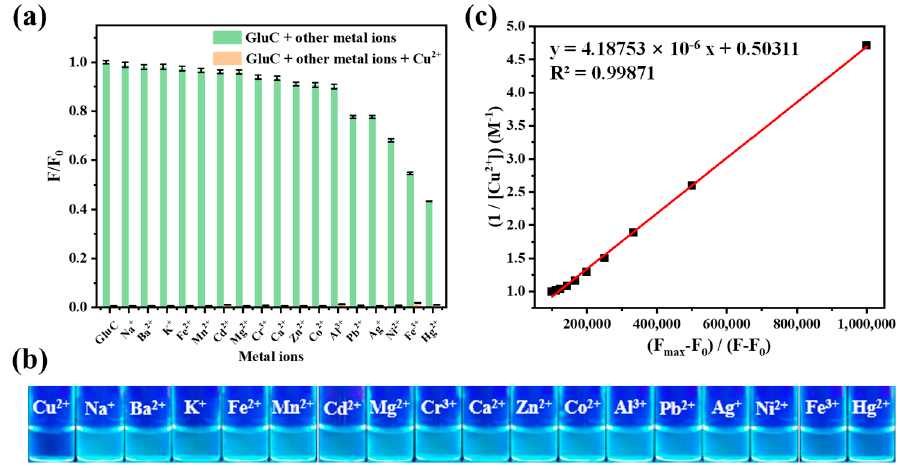
Figure 1. ( a ) The influence of different metal ions (20.0 μ M) to fluorescence intensity of GluC (10.0 μ M) at 494 nm followed by adding Cu 2+ (20.0 μ M) in water ( n = 3, “ n ” means number of experiment repeats); ( b ) Visible color changes of GluC (10.0 μ M) under UV light (365 nm) when adding various metal ions (20.0 μ M); ( c ) The Benesi - Hilderbrand plots of GluC with Cu 2+ .